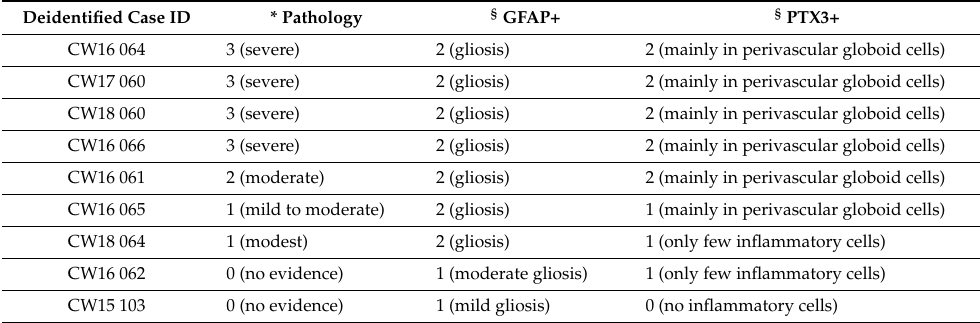
Figure 1. PTX3 immunolocalization in the brain of Krabbe patients. ( A ) Representative images from Krabbe brain cortex specimens showing the classical histopathological hallmarks of the disease in the white matter, with diffuse infiltration of macrophages (globoid cells) mainly distributed around the blood vessels (left image, H&E). Immunostains for PTX3 (brown) and GFAP (brown, middle and right images, respectively) show intense and diffuse immunoreactivity of PTX3 and gliosis. ( B ) Double immunostainings from Krabbe and control brain cortex samples. The large majority of CD68 + monocyte-derived cells (blue) are intensely immunoreactive for PTX3 (brown) within the white matter of Krabbe patients (left image), while reactive GFAP + astrocytes (blue) expressing PTX3 (brown) are barely detected (middle left image; asterisk). Conversely, no PTX3 + or CD68 + cells were detected in these samples, except for rare circulating CD68 - PTX3 + monocytes within the vessels (middle right image), and PTX3 was not detected in resident GFAP + astrocytes from control matched brains (right image). Original magnification: 40× ( A ); 60× ( B ). Scale bars: 50 μ m ( A ); 30 μ m ( B ). Table 1. GFAP/PTX3 immunostaining in Krabbe patients.